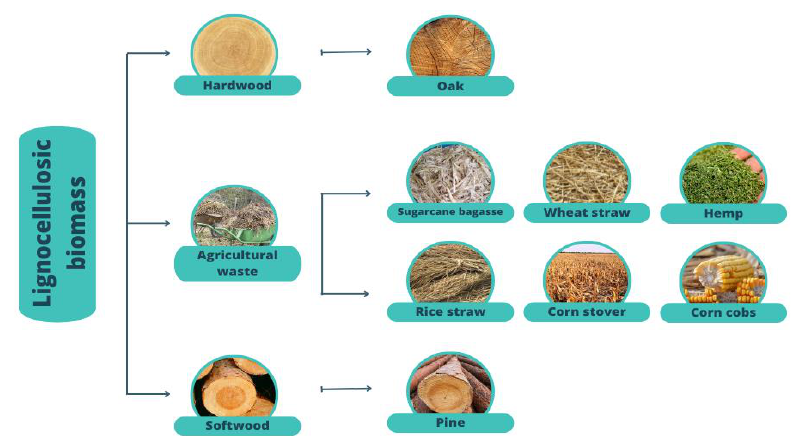
Figure 3. The three types of lignocellulosic biomass with some examples of each.